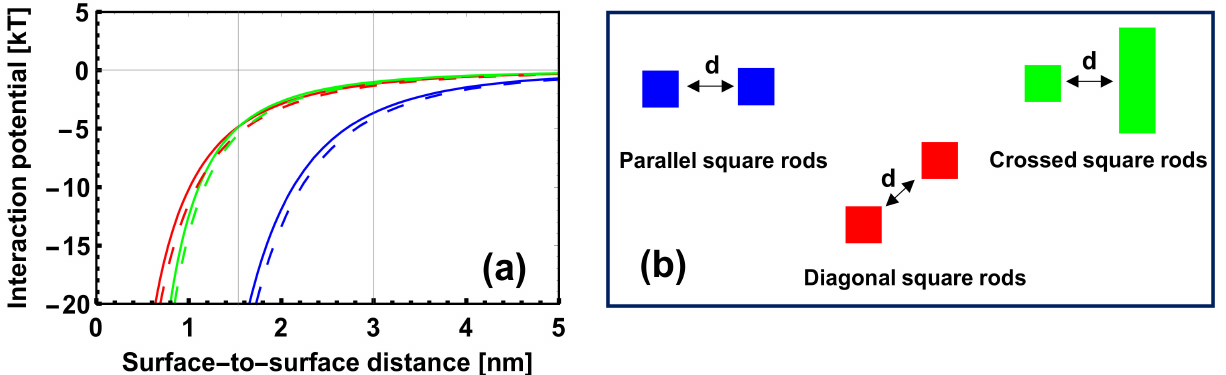
Figure 6. ( a ) van der Waals interaction potentials between two bare TiO 2 NRs of anatase (solid lines) and brookite (dashed lines) phase of the same size in toluene. Vertical gray solid lines represent one and two times the effective ligand length of 1.5 nm corresponding to the interparticle spacing observed in the TEM images. ( b ) Schematic representation of NRs encounter each other in parallel, diagonal, or crossed configuration shown in blue, red, and green colors, respectively. Nanorods are assumed as parallelepipeds of length 27.4 nm and thickness 3.4